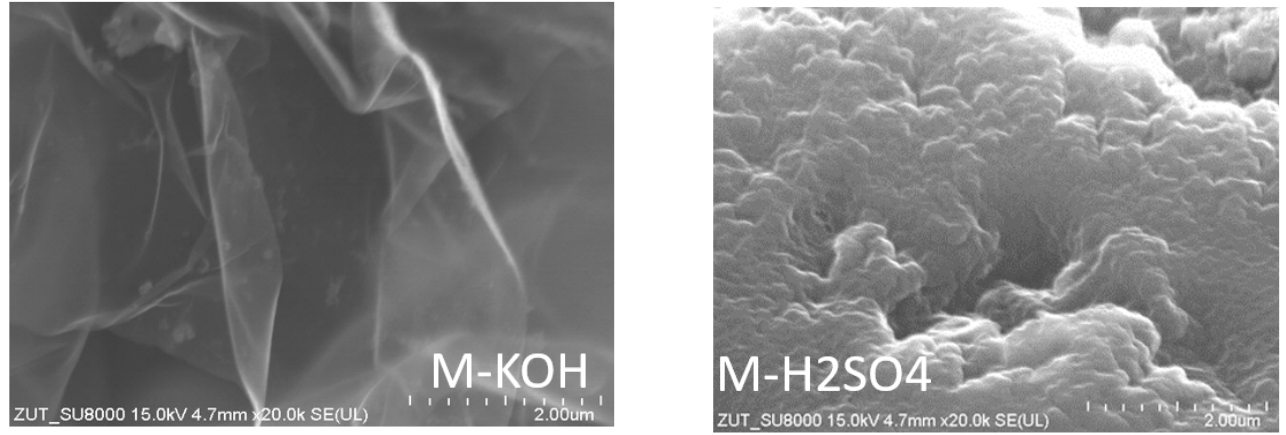
Figure 3. SEM pictures of the activated carbon produced from molasses.